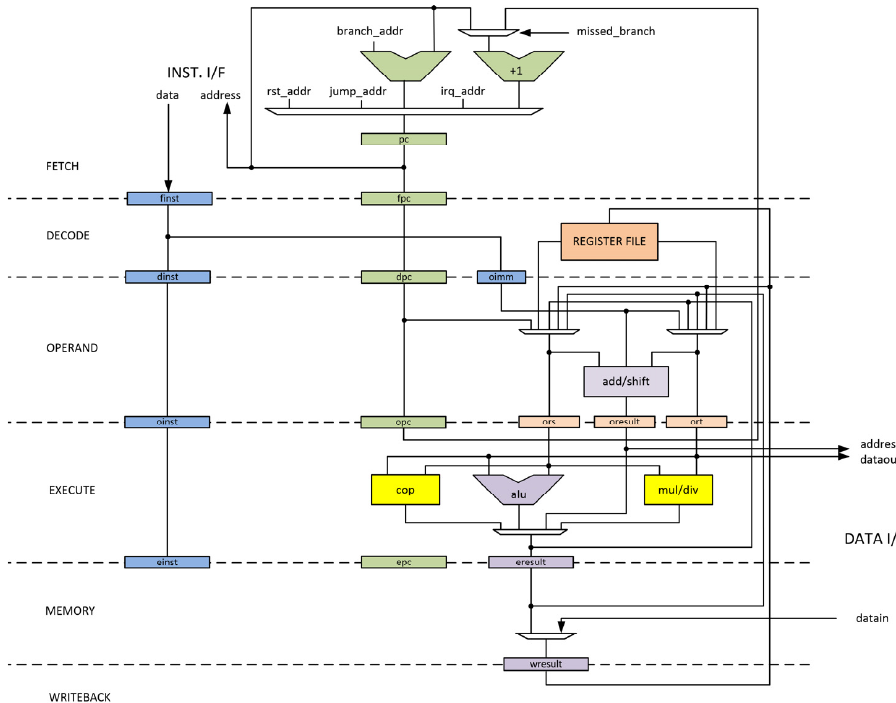
Figure 2. Integer unit datapath of the CCRV32ST processor core.